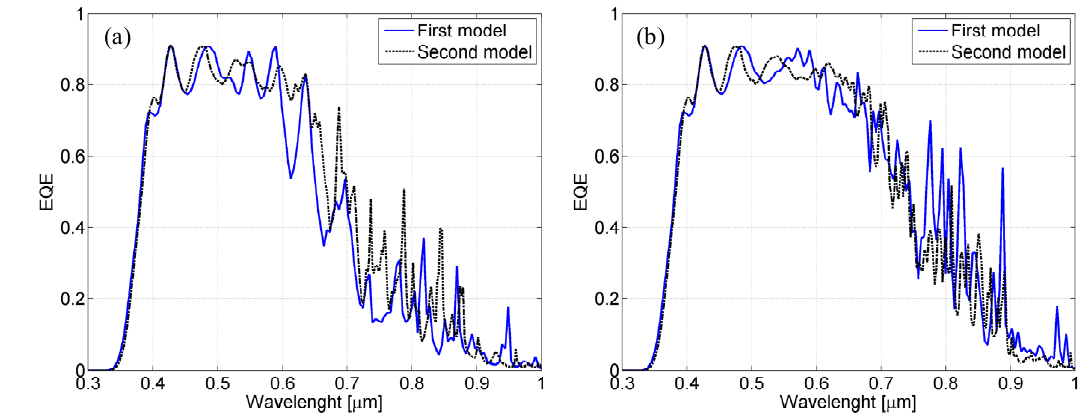
Figure 12. EQE spectra retrieved from the simulation with the simplified and improved numerical models for the textured cell with 800-nm-thick ( a ) and 1500-nm-thick ( b ) silicon